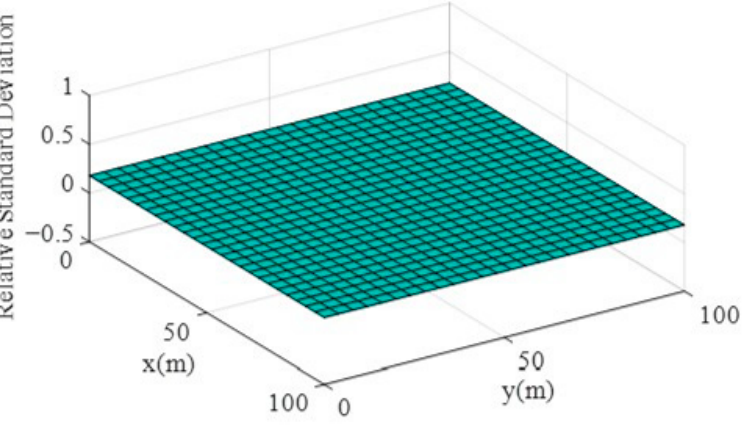
Figure 9. Relative standard deviation of energy response of the membrane with a random length in space